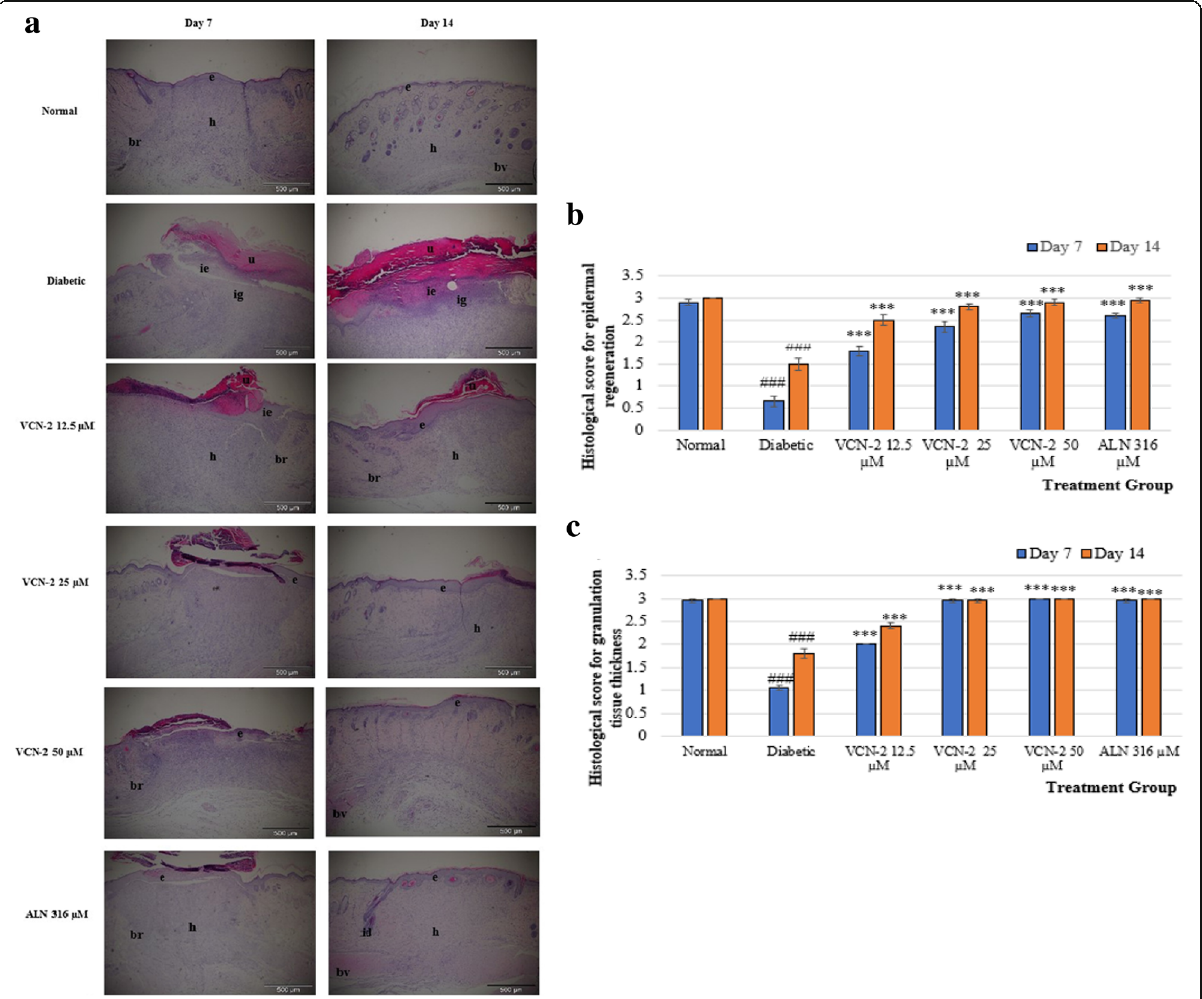
Fig. 2 a Images of healed wound site from a normal rat and diabetic rat with blank, VCN-2 and allantoin dressing treatment on day 7 and 14. Normal rat demonstrating complete re-epithelialization and well-form granulation tissue. Diabetic rat treated with VCN-2 12.5, 25 and 50 μ M film consequence re-epithelialization and well-formed granulation tissues on day 7 and 14, (100x with H&E stain). Abbreviation (br): boundary between unhealed and healed tissue; (bv): blood vessels; (h): healed area with multiple layers of fibrous connective tissue; (e): epithelium; ie): immature epidermis; (ig): immature granulation tissue and (u): ulcer. b Histologic scoring for epidermal regeneration. c Histologic scoring for granulation tissues thickness of the rats on day 7 and 14 from 10 randomly chosen fields. Data expressed as means ± SEM ( n =6). ### p <0.001 is diabetic group compared with normal group; *** p <0.001 is treated group compared with diabetic group on the same